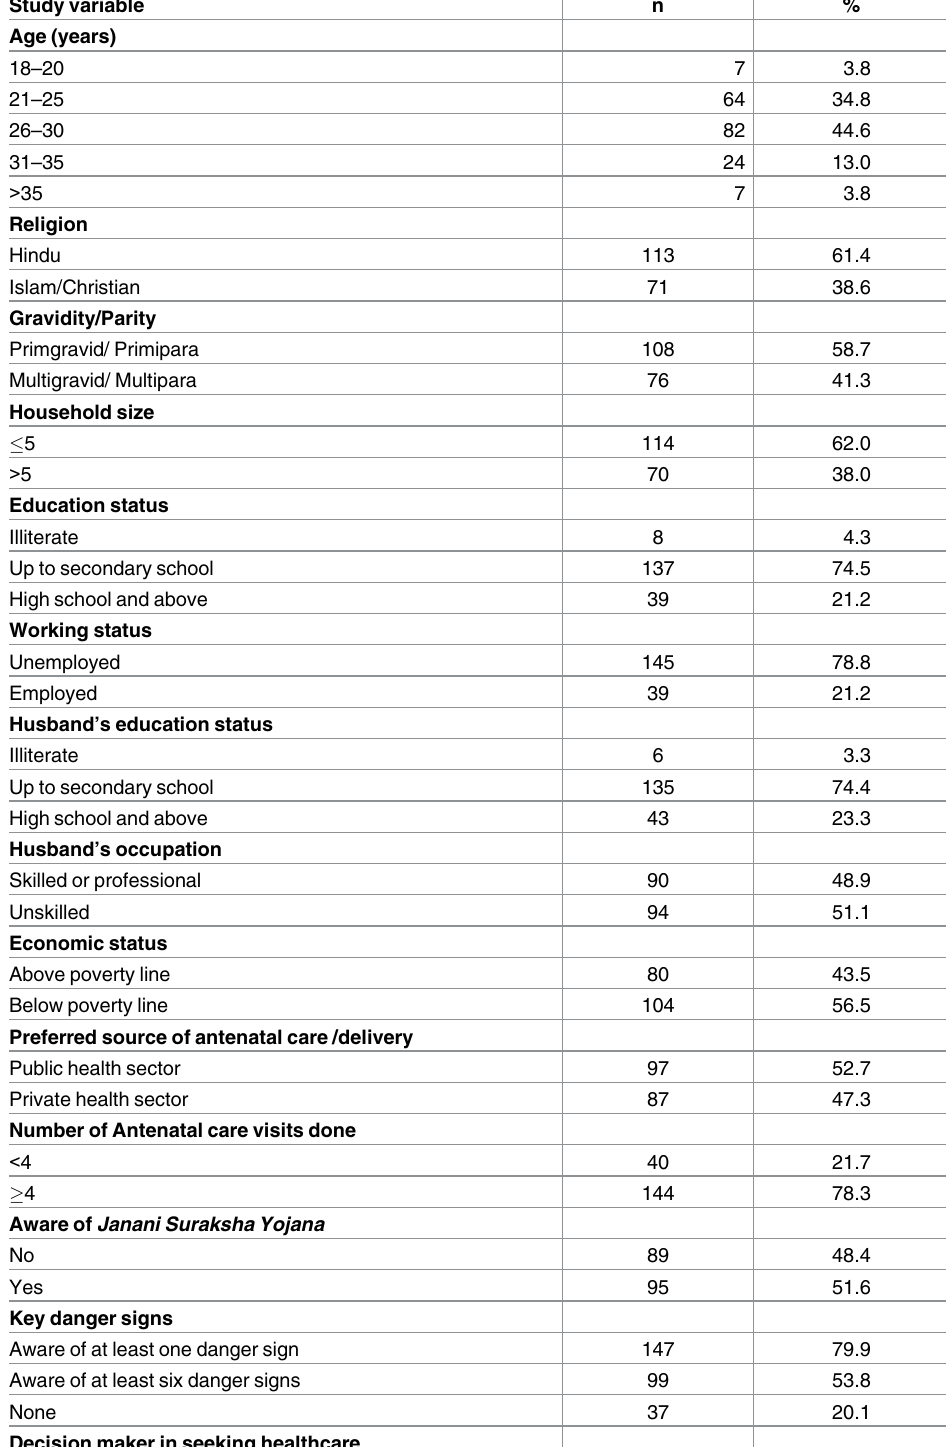
Table 1. Socio demographic and obstetric parameters of pregnant ( (cid:21) 28 weeks of gestation) and recently (within 6 months) delivered women attending two rural primary health centers, Dakshina Kannada district, Karnataka,India, June-September 2013(n =